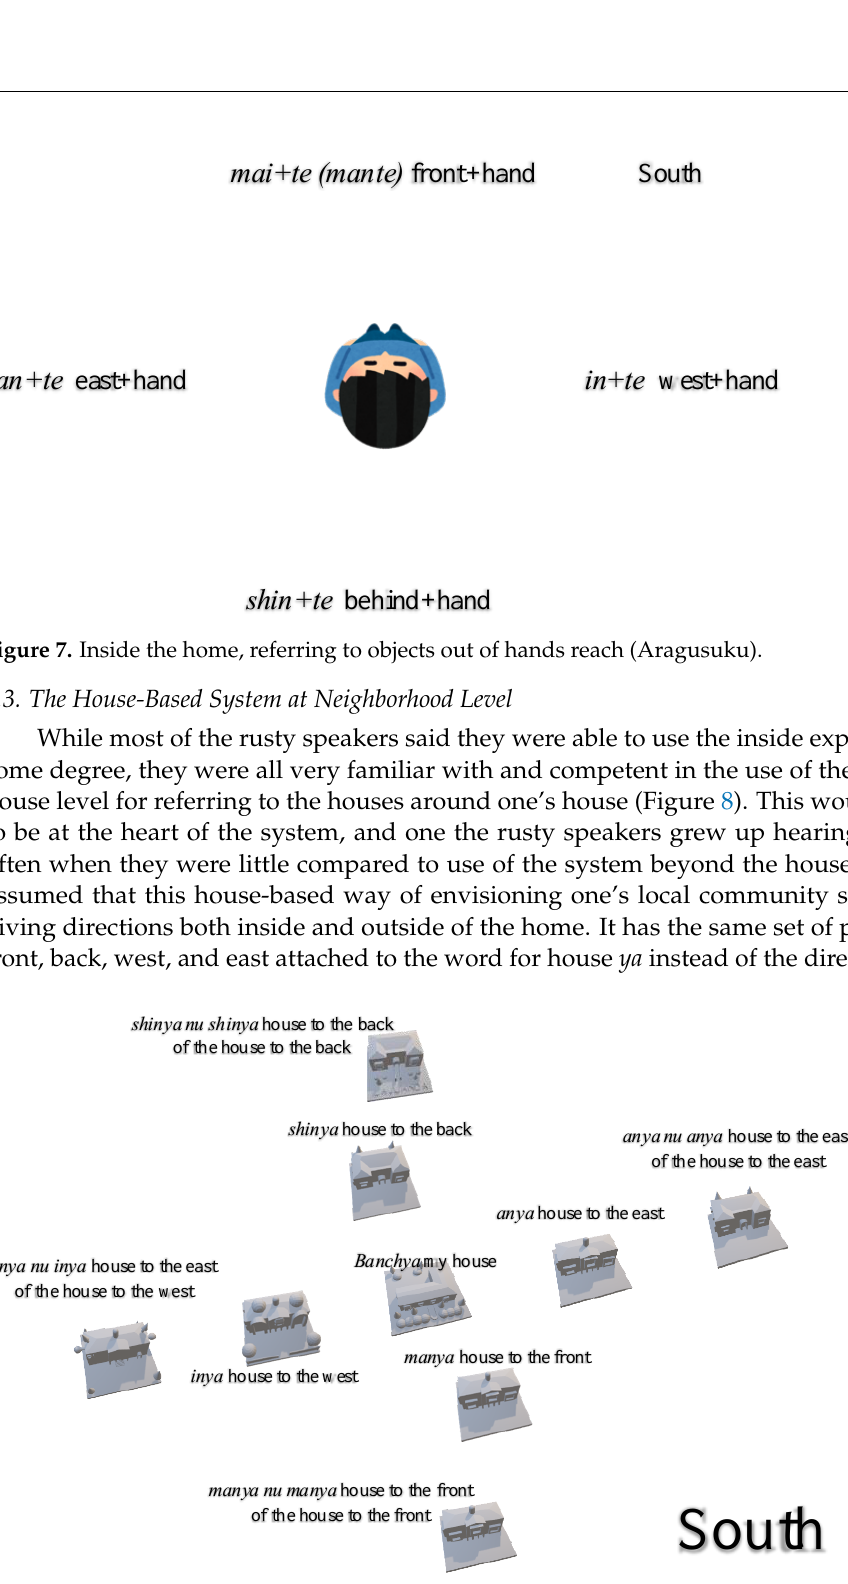
Figure 8. System for referring to the neighboring houses (Shikāza and Aragusuku).